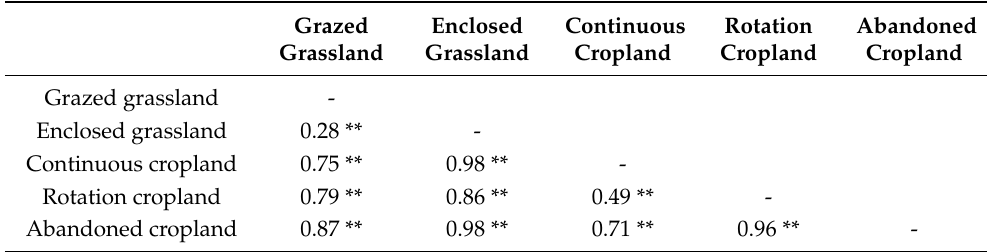
Figure 4. Non-metric multi-dimensional scaling (NMDS) ordination of relative abundance ( a ) and clustering by weighted unifrac distance ( b ) for soil bacterial OTUs under the five land use patterns. We applied Anosim analysis to detect the significance of land use effects on soil bacterial beta diversity (Table 2). R values were all significantly positive, and ranged from 0.28~0.98, indicating the difference between land use patterns was significantly stronger relative to the difference within land use patterns. Table 2. Anosim analysis between the five land use patterns for soil bacterial communities under the five land use patterns in Tianzhu alpine agro-pastoral ecotone. Data represent R values and significance were indicated by “**” ( p < 0.01).